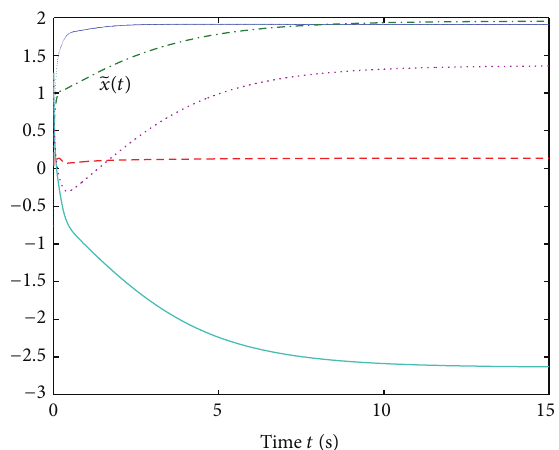
Figure 3: Neural state ̃𝑥(𝑡) of QP problem (15) by the GNN model (14) with the usage of power-sigmoid function and design parameter 𝛾 = 1